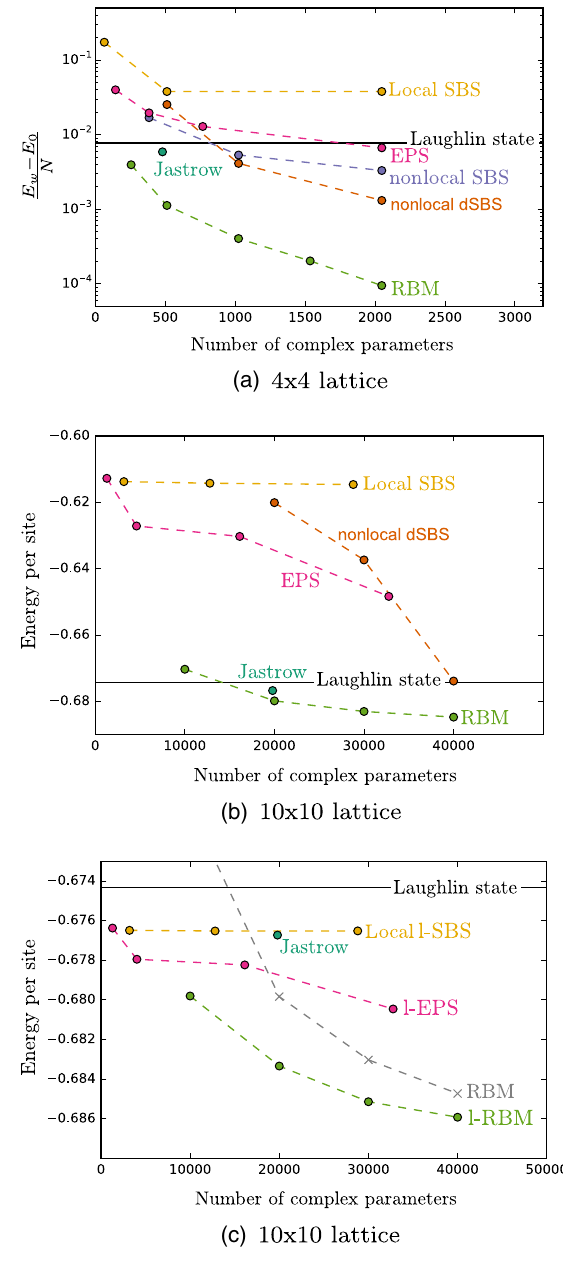
FIG. 5. Energy of H l per site for different optimized Ansatz wave functions on a square lattice. The number of parameters ( N p ) is modified by increasing the bond dimension D (local SBS, N ∝ D 2 ), the size of the plaquettes (EPS, N ∝ M 2 P , where p p P M P is the number of spins in P is the number of plaquettes and one plaquette), the number of strings M S (nonlocal SBS and dSBS, N p ∝ M S ), or the number of hidden units M h (RBM, N ∝ M 4 × 4 lattice for which the energy difference p h ). (a) The with the exact ground-state energy is plotted. (b) The 10 × 10 lattice for which the exact ground-state energy is unknown and the reference energy of the Laughlin state is indicated as a black line. (c) Optimization of wave functions that have been multiplied by the Laughlin wave function on a 10 × 10 lattice. The original RBM results are indicated for reference as grey